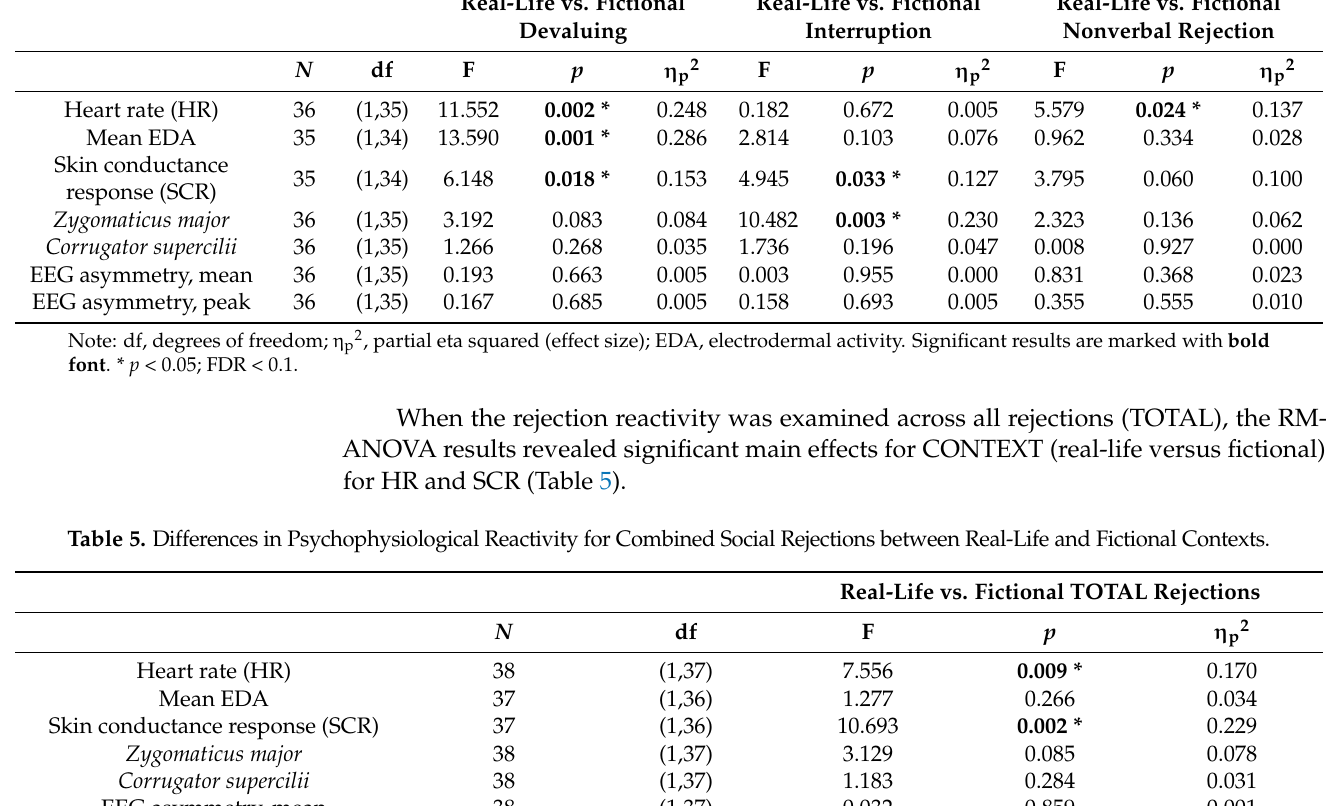
Table 4. Differences in Psychophysiological Reactivity between Real-Life and Fictional Social Rejections. Real-Life vs. Fictional Real-Life vs. Fictional Real-Life vs. Fictional Devaluing Interruption Nonverbal Rejection